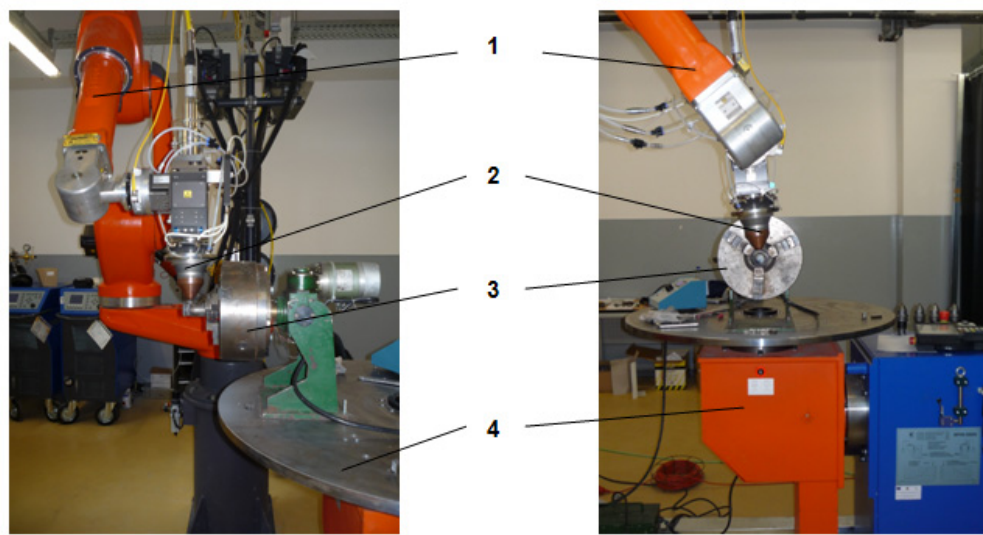
Figure 4. Experimental assembly used for laser metal deposition using a robotic cell: (1) welding robot; (2) processing head-laser deposition module; (3) tooth rotating and positioning device; (4) rotating and positioning table.